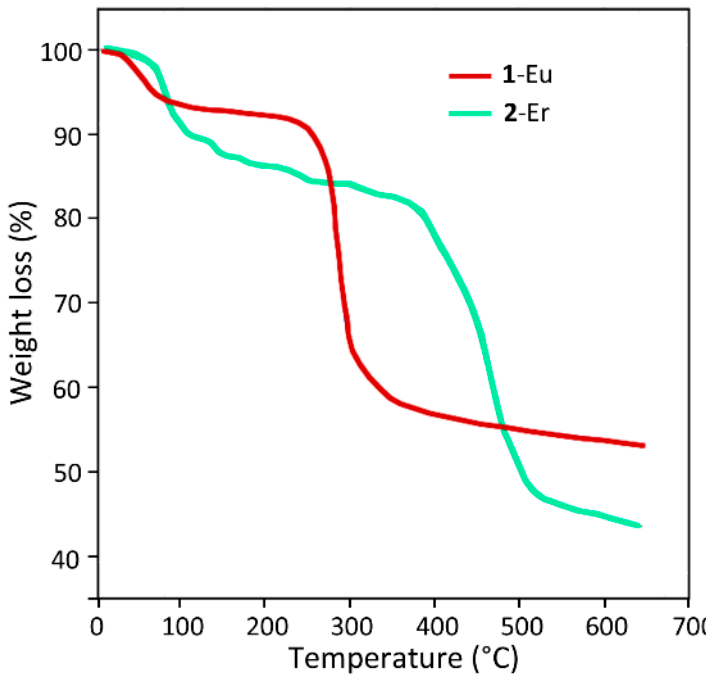
Figure 4. Thermogravimetric curves for 1 -Eu (red) and 2 -Er (green).